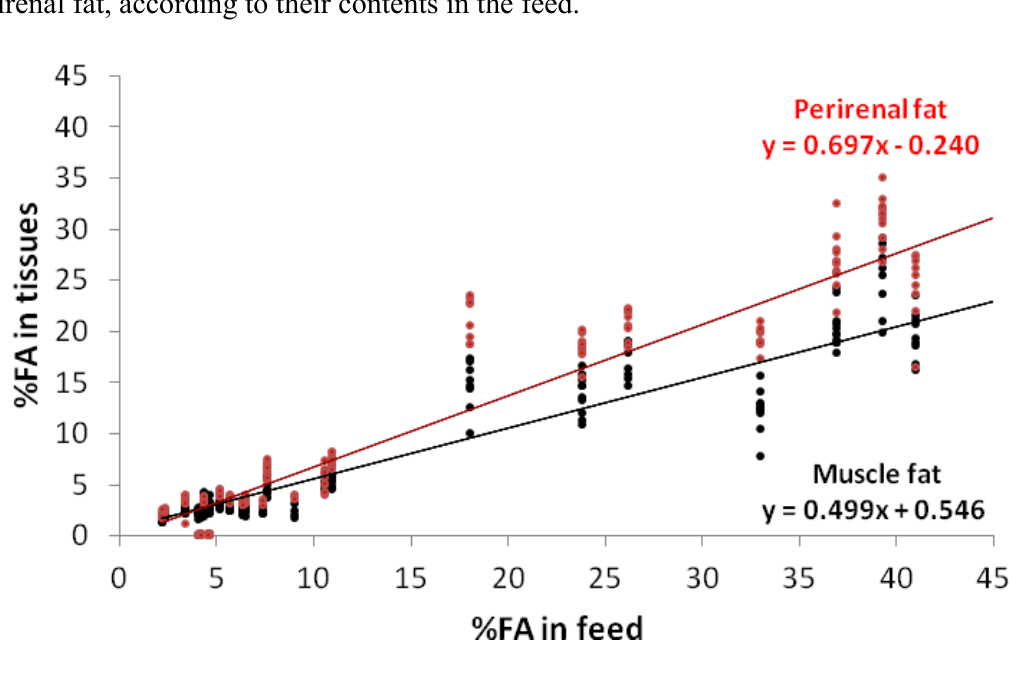
Figure 1. Regressions of the α -linolenic acid (C18:3 n-3) contents in the muscle fat and perirenal fat, according to their contents in the